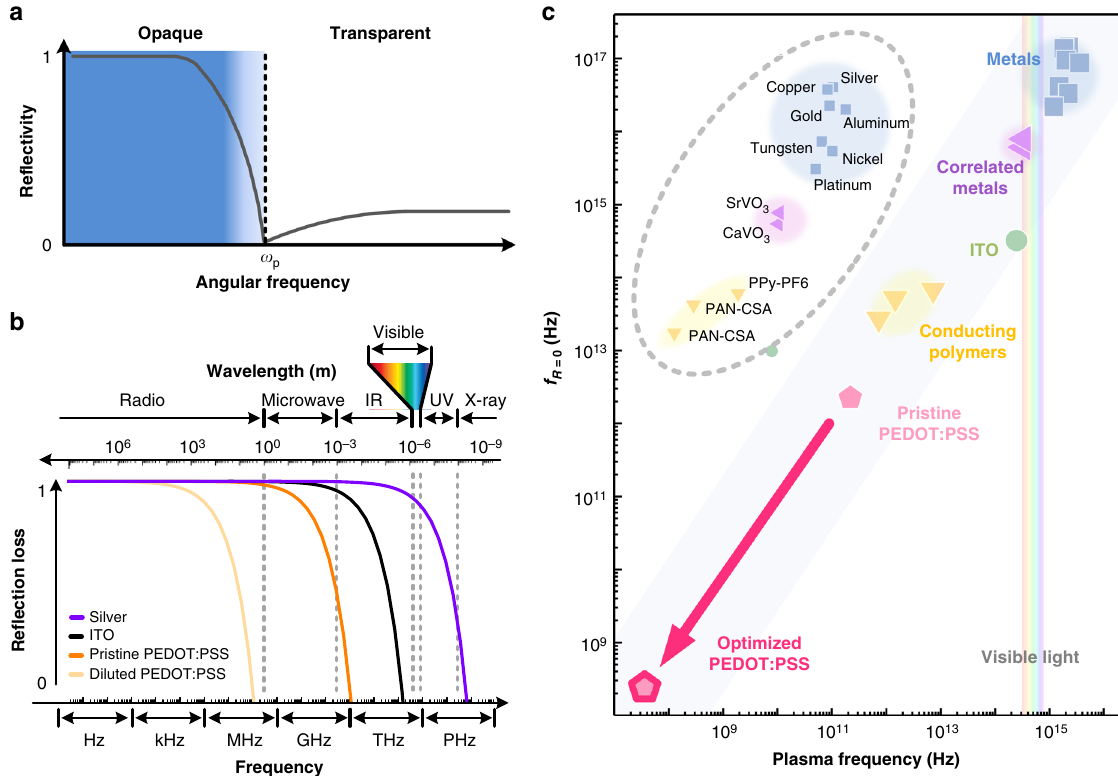
Fig. 1 Relationship between plasma frequency and re fl ection for transparent conductors. a Schematic of increase in light transmission (decrease in re fl ectivity) of metals for frequencies beyond the plasma frequency. b Frequency-dependent re fl ection loss R of four materials (silver, indium tin oxide (ITO), pristine poly(3,4-ethylenedioxythiophene):-poly(styrenesulfonate) (PEDOT:PSS), and diluted PEDOT:PSS) calculated by intrinsic impedance. c Correlation between vertical intercept ( R = 0) of re fl ection loss curve, f R = 0 , calculated by σ and plasma frequency ω p that is proportional to electron concentration